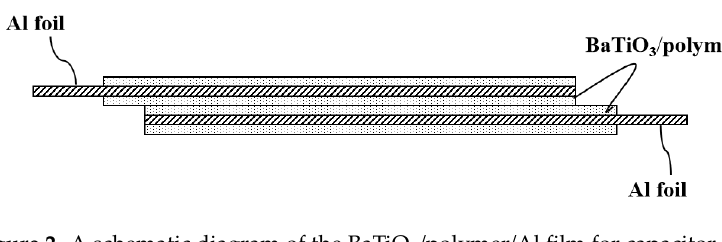
Figure 2. A schematic diagram of the BaTiO 3 /polymer/Al film for capacitor cells.